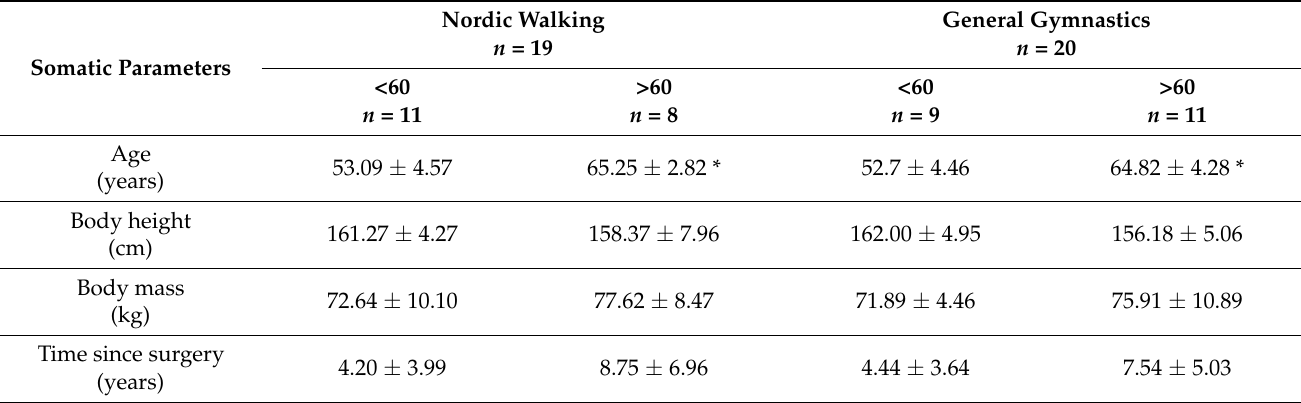
Table 3. Somatic parameters and the time since treatment in the study and control